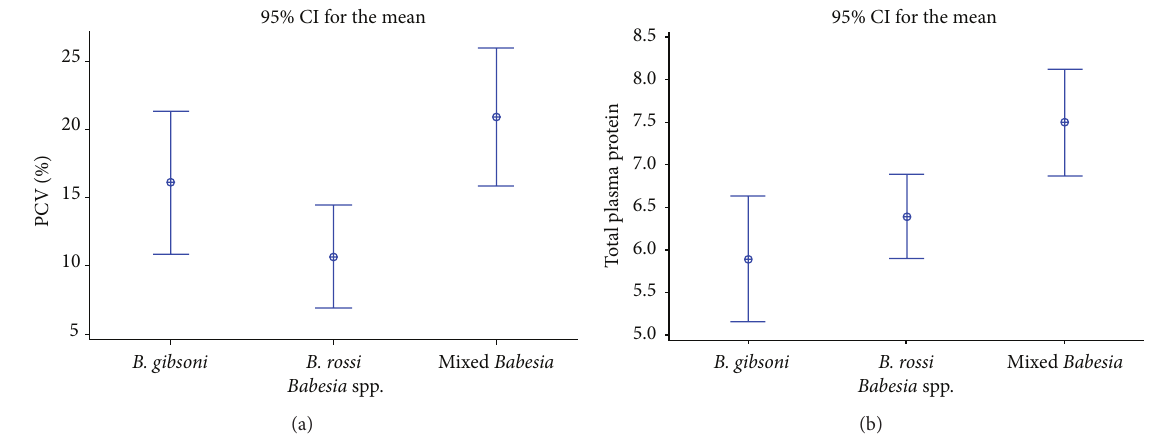
Figure4:Intervalplotsofpackedcellvolumevalues(a)andtotalplasmaproteins(b)indogswithsingleandmixed Babesia speciesinfections.